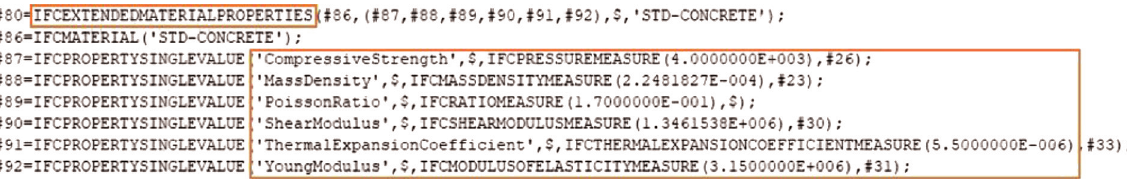
Figure 11: Material information representation implementations in IFC